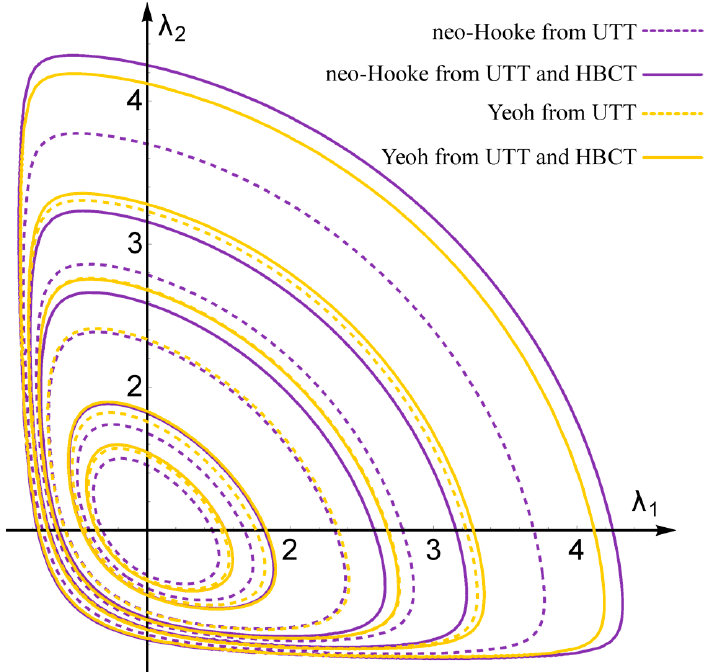
Figure 9. Contour plots of the SEDF for the data and models considered. The following contour lines correspond to the following SEDF values: 0.5, 1, 3, 5, 10 (MJ/m 3 ). In order to experimentally verify the results obtained, LBCT was performed for each of the four determined parameter sets and the normalized mean squared error of the curve fit was calculated. The bar chart in Figure 10 and Table 4 shows the results obtained.